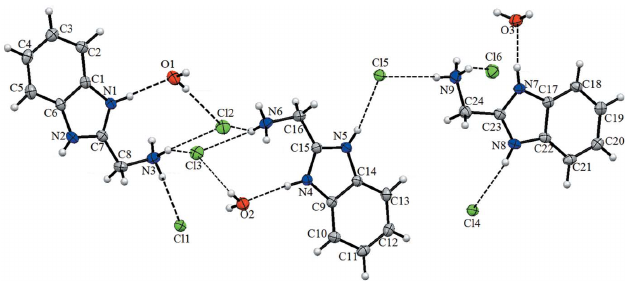
Figure 1 The molecular structure of the title compound, showing the atom labelling. Displacement ellipsoids are drawn at the 20% probability